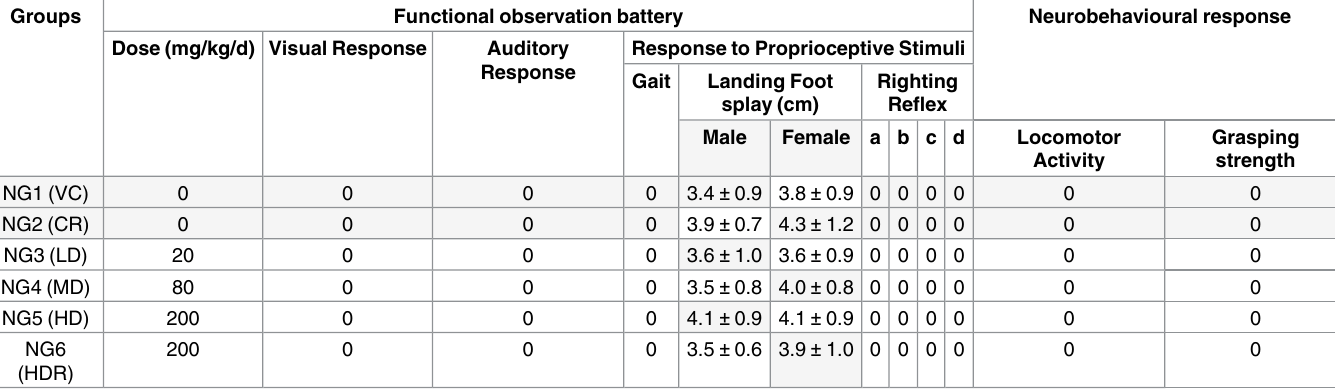
Table 2. Effect of 90 day oral administration of 3’-HPT on functional observation battery (neurobehavioural assessment)tests in male and female SD rats. Groups